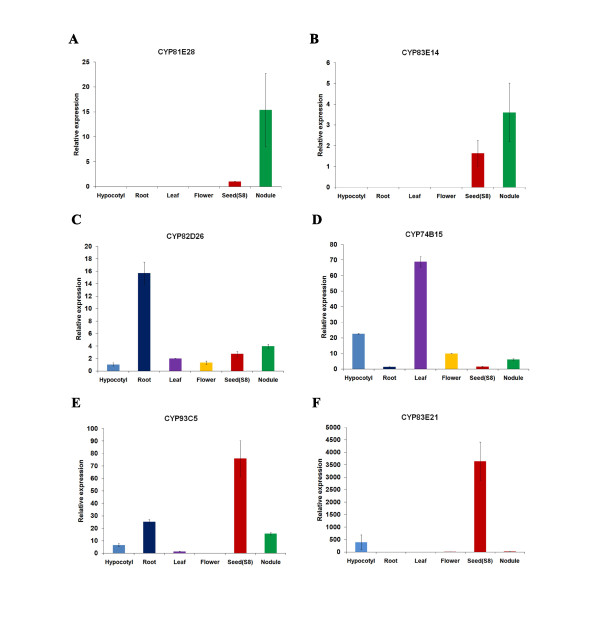
qRT-PCR confirmation of soybean P450 gene expression in different organs as revealed by the analysis of Microarray and Solexa transcriptome datasets. Error bars represent SE of three replications.